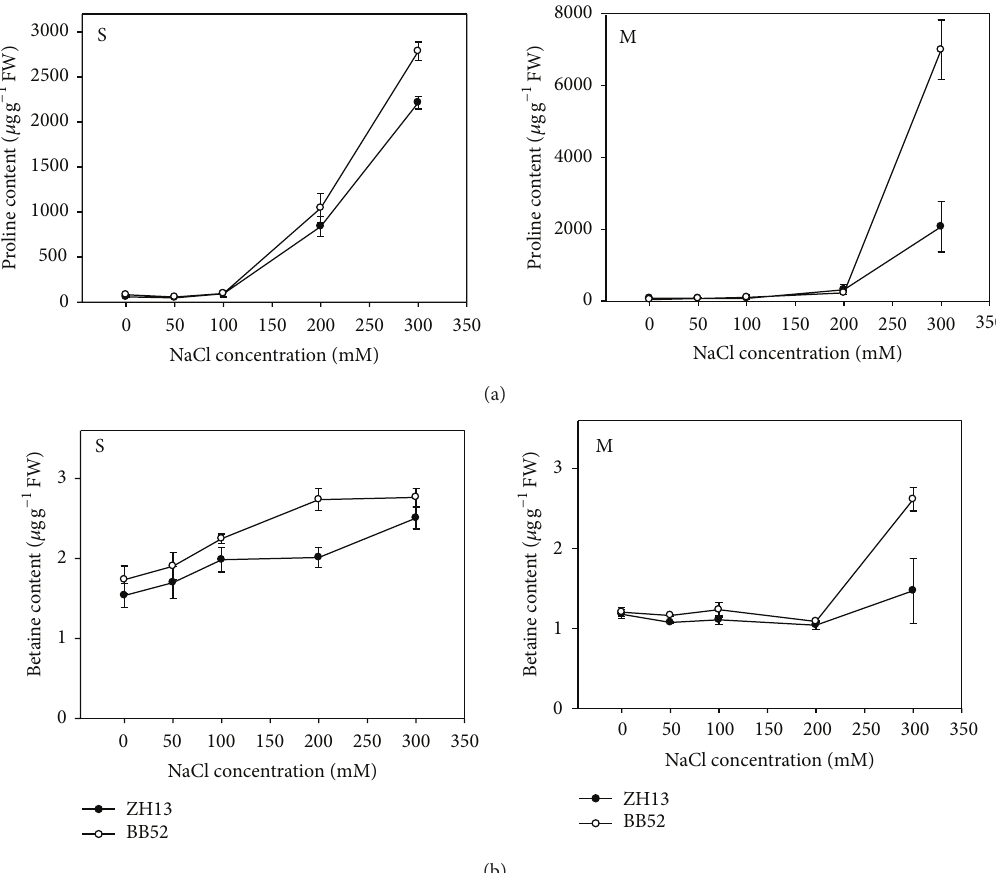
Figure 2: Effects of salt stress on proline (a) and glycine betaine (b) accumulation. S stands for seedlings and M stands for mature seedling in the